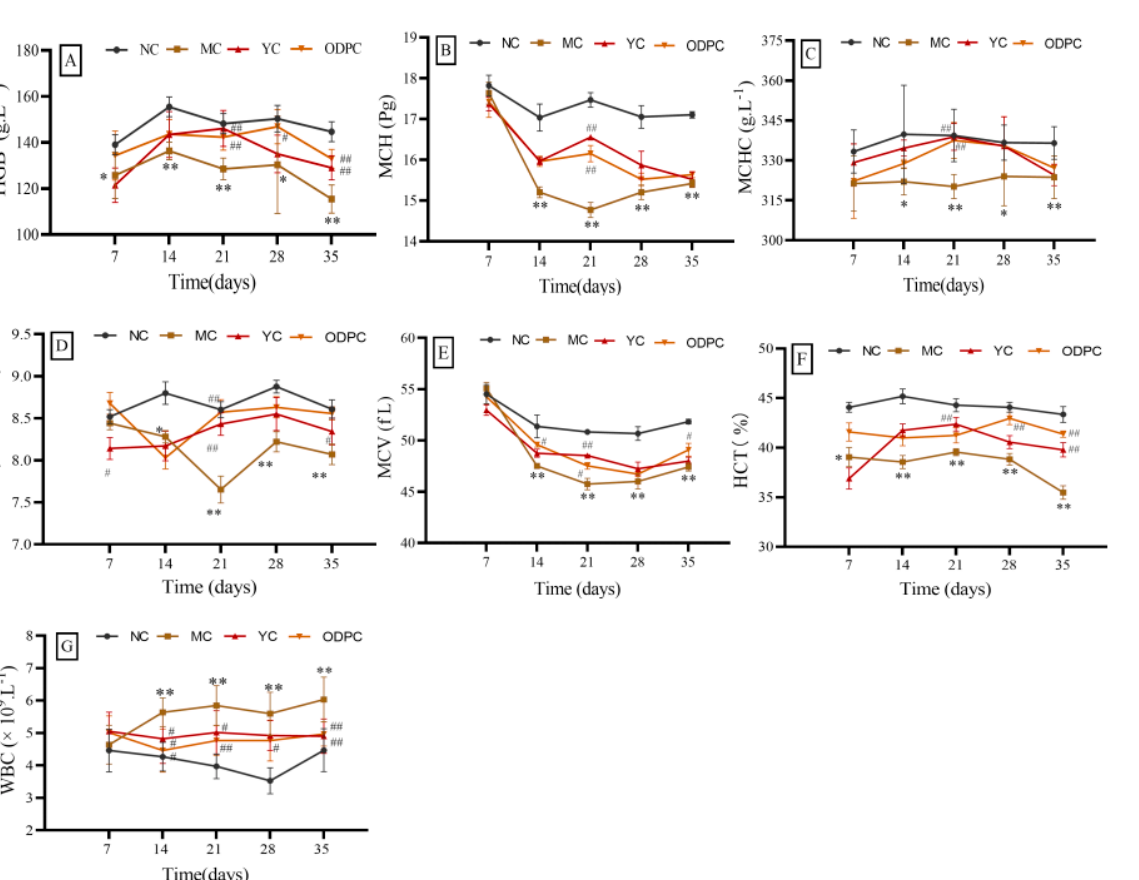
Figure 3. Effects of cadmium exposure on hematological indicators of mice: ( A – G ) are HGB, MCH, MCHC, RBCs, MCV, HCT, and WBCs, respectively. NC: normal control group, MC: CdCl 2 -treated group. * Compared with normal control group (NC group), **, p < 0.01.